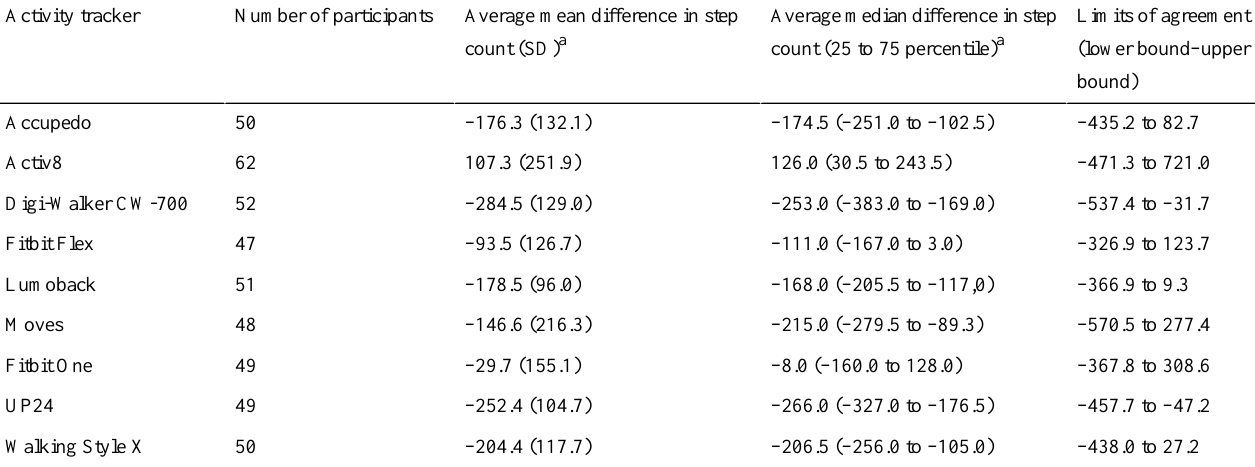
Table 4. Descriptive statistics of step count by activity tracker compared to the gold standard.